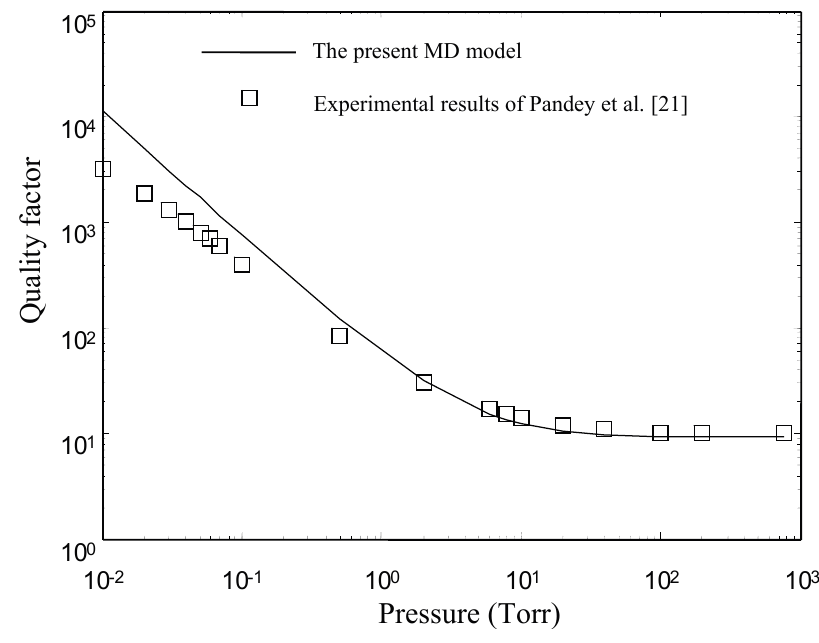
Figure 13. Comparison of the quality factors obtained by the present model to the experimental results of Pandey et al.